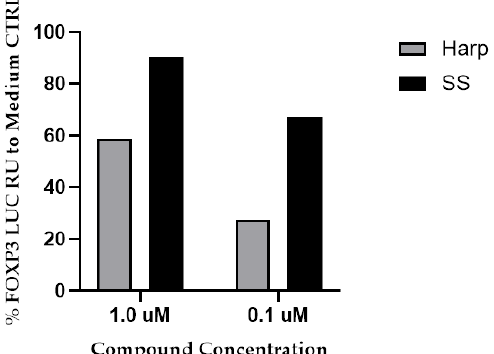
Figure 1. The induction of FoxP3 promotor by the hit molecules. Sparteine sulfate (SS) or harpagoside (Harp) (1 or 0.1 μM) was added to the HEK 293-FoxP3 reporter cell line for 16 h. Cells were then lysed, and luciferase activity was measured. Response units (RU) were adjusted in relation to response in wells with media + puromycin (CTRL). The % Foxp3 induction is calculated as [(luminescence for test molecule × 100) / luminescence for medium CTRL] − 100. The two library replicates of diluted plates were run on separate days, and there were no experimental replicates.